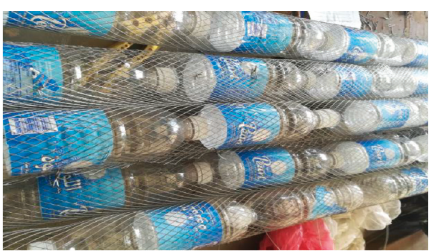
Figure 2: The manufactured steel wire mesh tubes filled with waste plastic